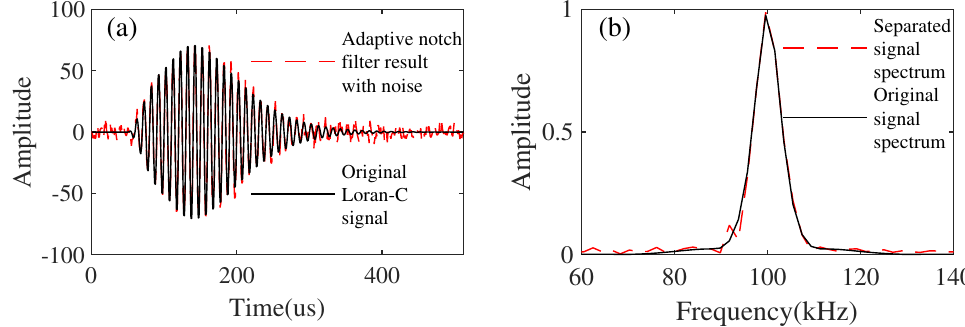
Figure 9. The results of CWI suppression using an adaptive notch filter with noise added. ( a ) The results of the adaptive notch filter with noise added. ( b ) Comparison of the separated signal spectrum and the original signal